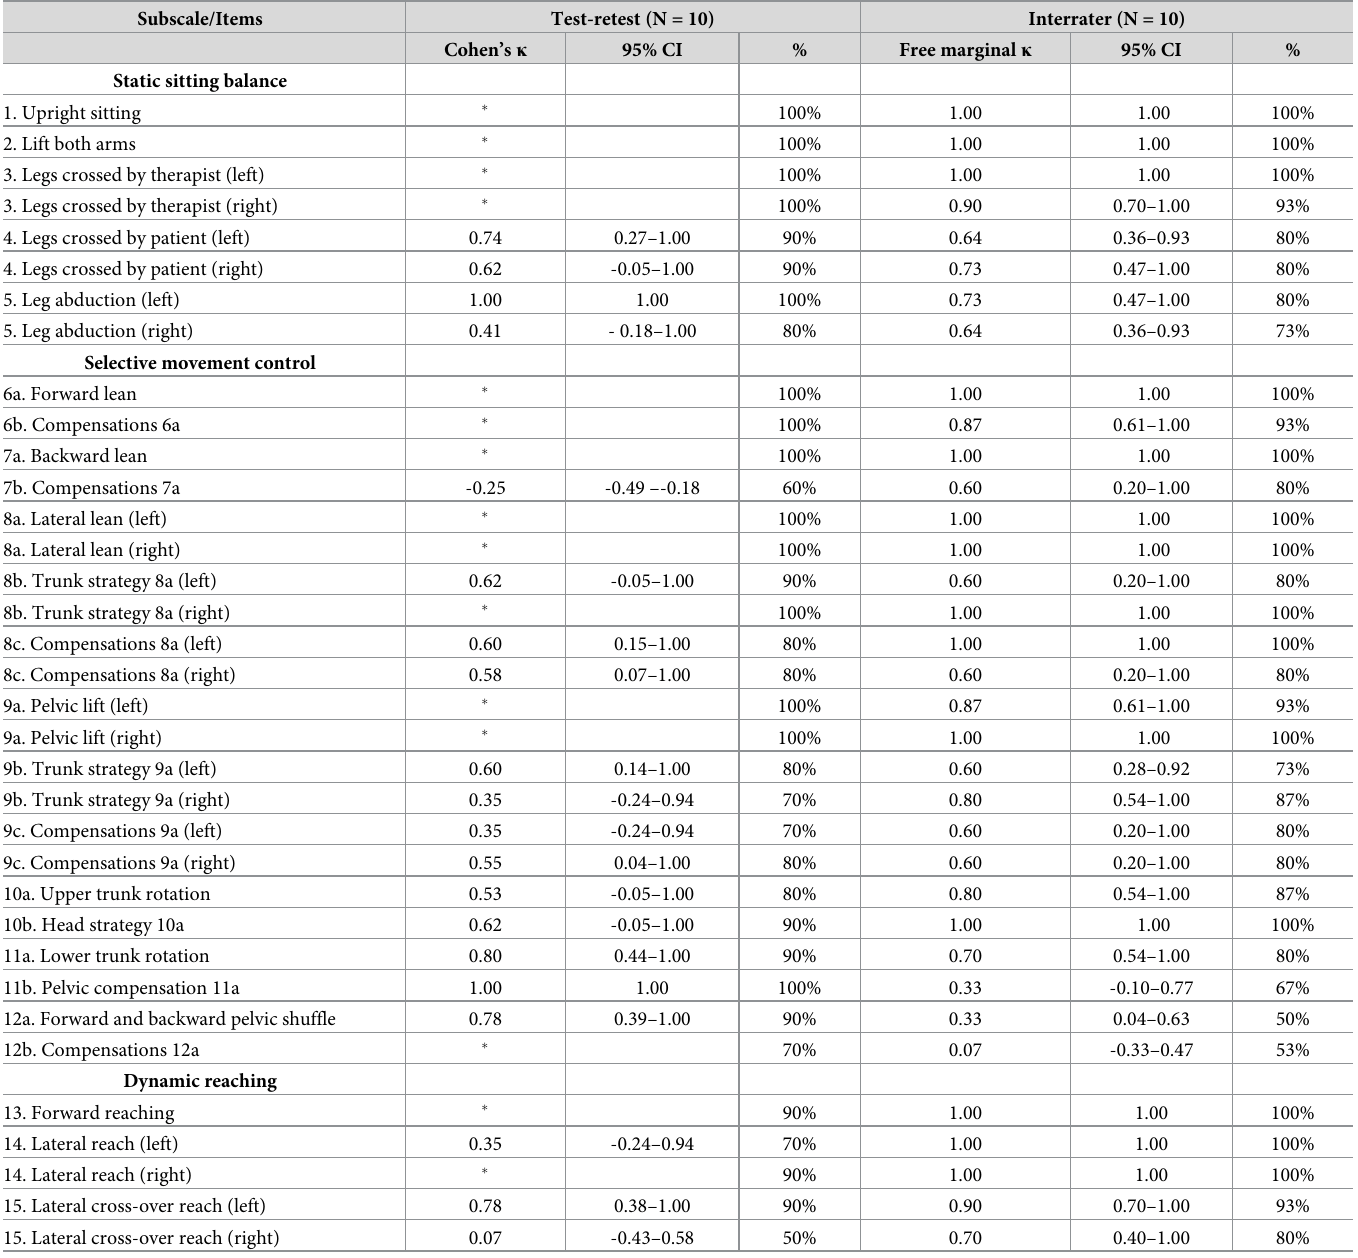
Table 3. Test-retest and interrater reliability of TCMS on item-level.